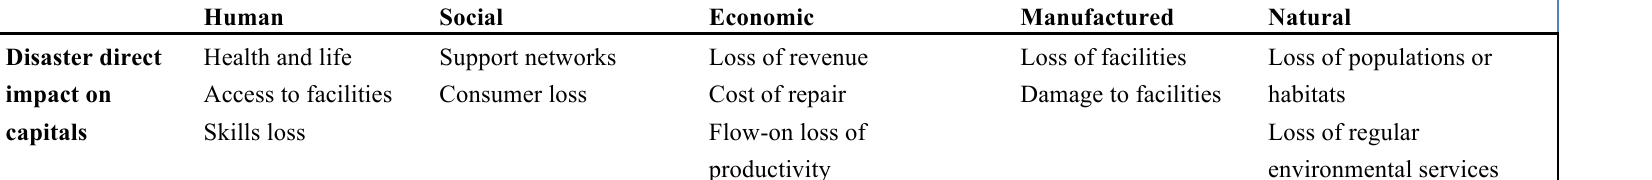
Table 5. Major risks of impact on the five capitals of generic natural disasters and alternative energy